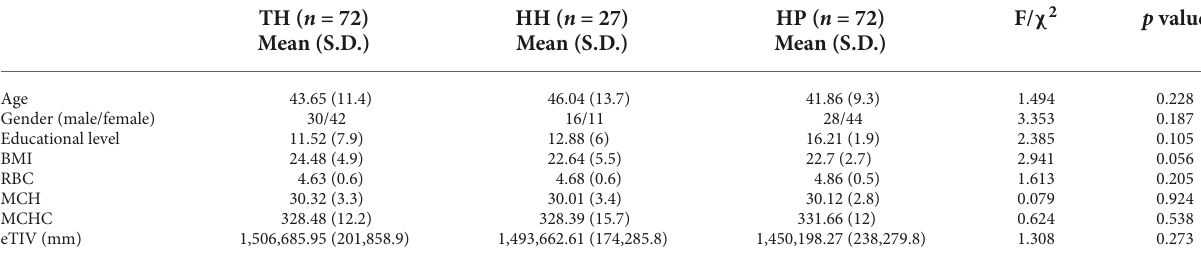
TABLE 1 Demographic and clinical data in Tibetans (TH) and in Han Chinese individuals living at High Altitude (HH) or on the Plain (HP). TH ( n = 72) HH ( n = 27) Mean (S.D.) Mean